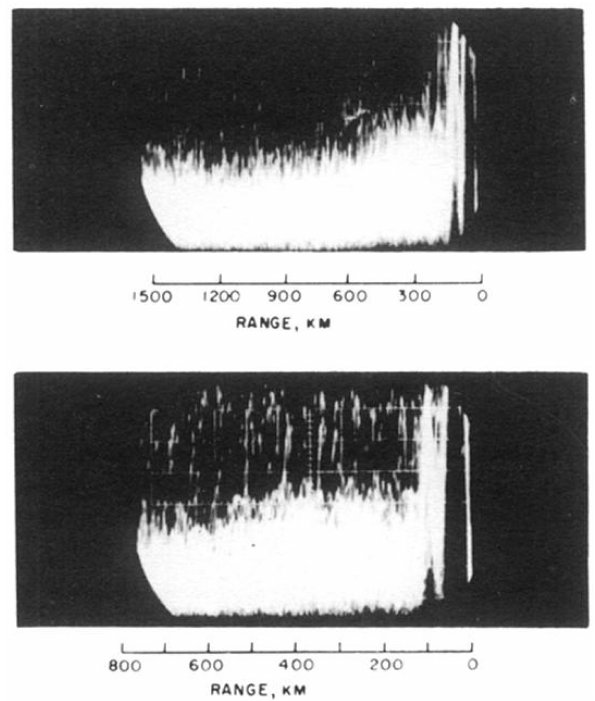
Figure 3. First incoherent scatter radar measurements conducted in October 1958 (adapted from Bowles, 1958). The top panel cor- responds to power measurements obtained using a pulse width of 140µs (21km) and a bandwidth of 10kHz. In the bottom panel, the measurements were obtained using a pulse width of 120µs (18km) and a bandwidth of